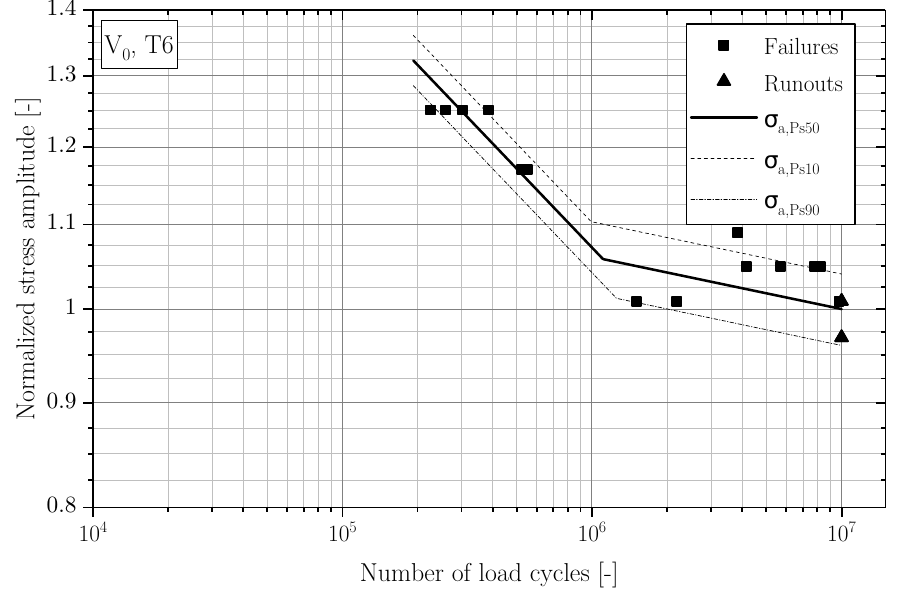
Figure 7. S/N curve of specimen